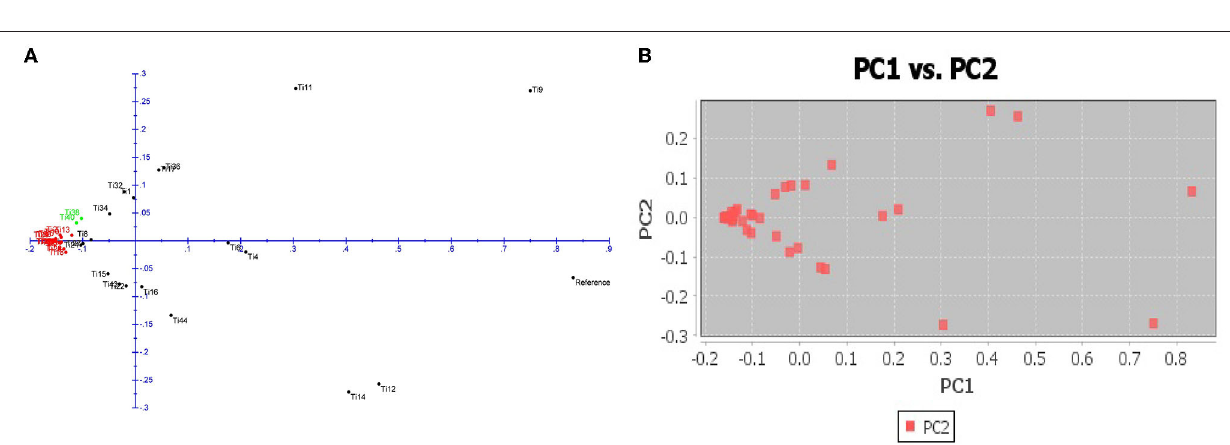
FIGURE 9 | (A) Principal coordinate analysis (PcoA) for 39 T. indica . The three colors correspond to the three clusters identified by the phylogenetic analysis. (B) Multi-Dimensional scaling (MDS) showing variation among the